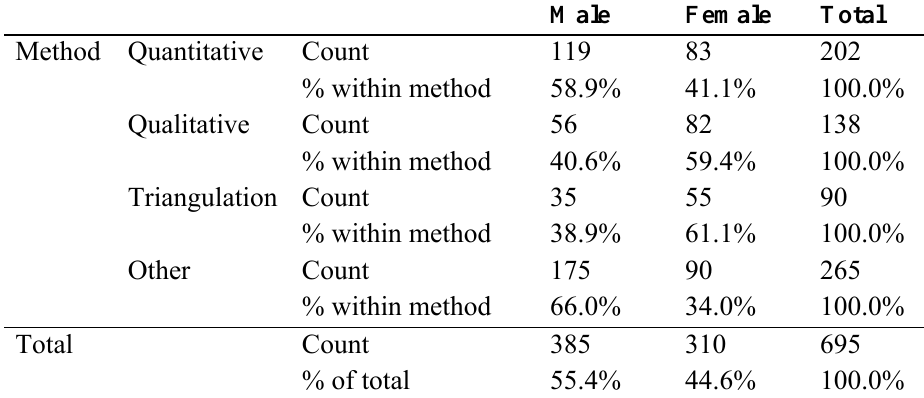
Table 10 Cross Tabulation of Gender (First Author) and Research Methods